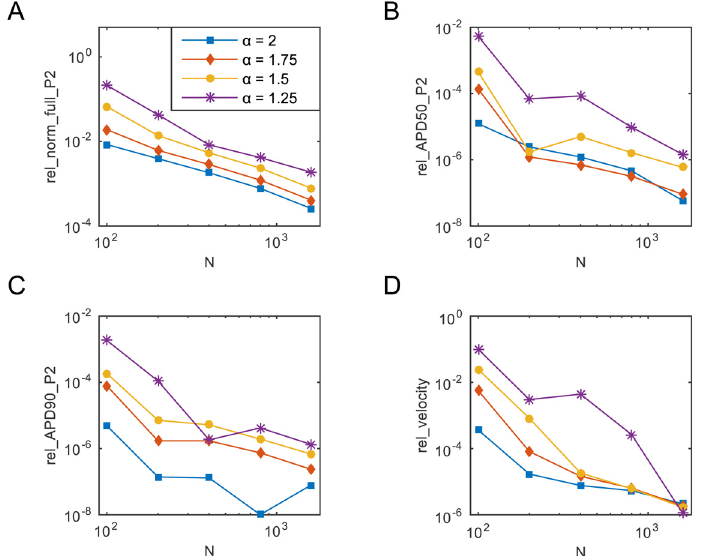
Fig 1. The four relative metrics as a function of the key parameter N (the number of eigenfunctions), for four selected values of α . The solution is computed for all values of α on the time interval [0,500 ms] with a uniform time step Δ t = 0.01 ms. All relative errors are evaluated by comparing the solution for a specific combination of α and N with the solution obtained for the same α when N = 3200. In all simulations, the stimulus I stim = 40 μ A (cid:3) cm − 3 was applied on [0,0.05 cm] at t stim = 10 ms for two consecutive milliseconds and then